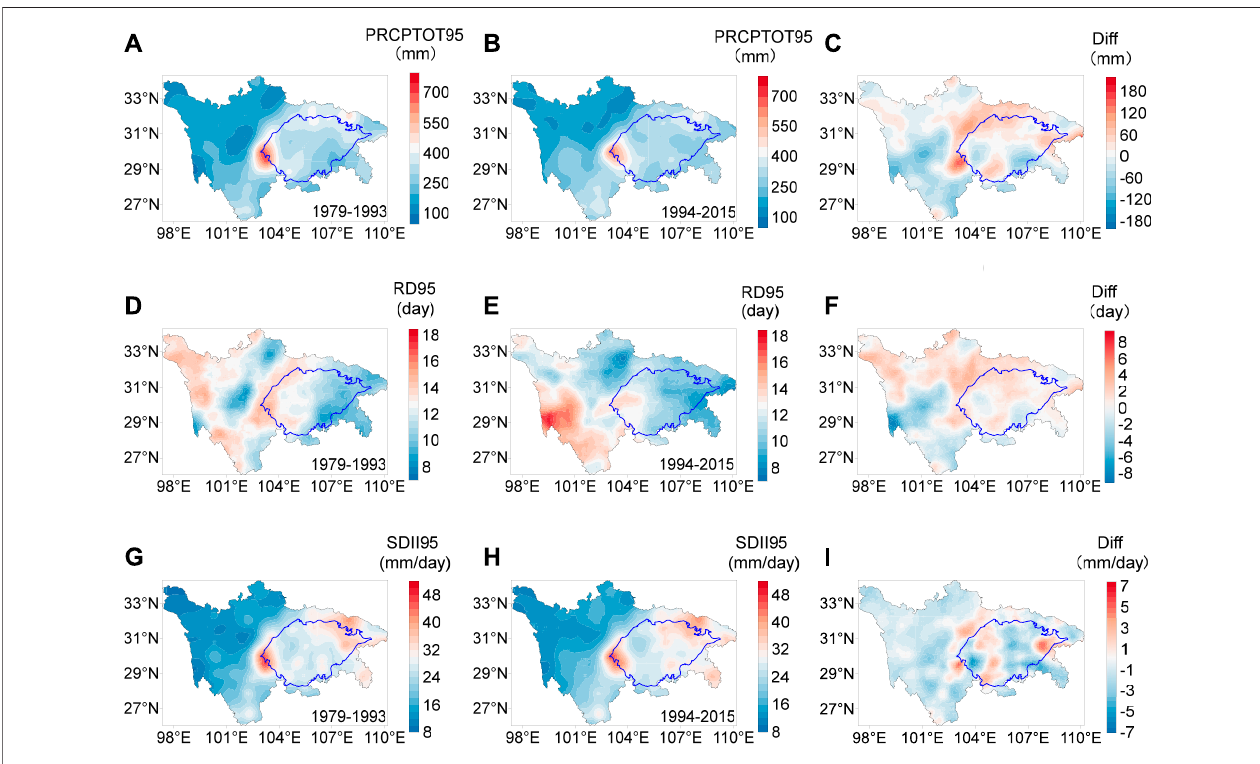
FIGURE 5| Distribution ofaverage annual extreme precipitation amount (PRCTOT95), extreme precipitation frequency (RD95), and extreme precipitation intensity (SDII95) in the Sichuan – Chongqing area: (A,D, and G) show the slow urbanization development stage (SUDS, 1979 – 1993); (B,E, and H) show the fast urbanization development stage (FUDS, 1994 – 2015); and (C,F, and I) show the differences in each grid between these two stages.